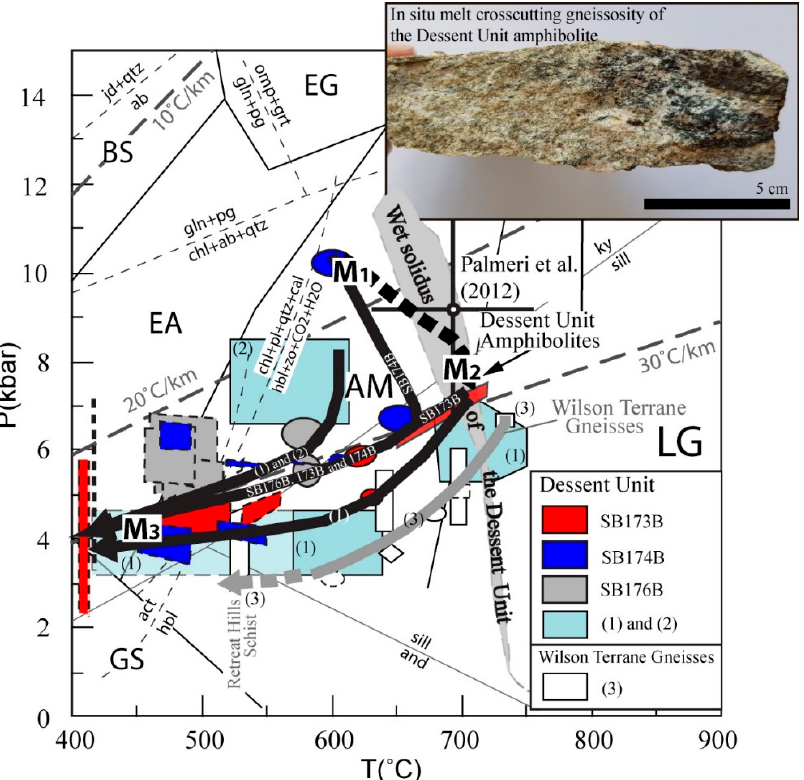
Figure 11. Summarized P–T paths of the Mountaineer Range, including the Dessent Unit and the Wilson Terrane gneisses. An amphibolite hand specimen hosting in situ melt collected from the Dessent Unit could represent its M 2 stage metamorphism. Prograde P–T conditions are presented as solid line polygons and retrograde P–T conditions as dot line polygons. Literature P–T conditions include (1) Scambelluri et al. [62]; (2) Capponi et al. [97]; (3) Castelli et al. [98]; (4) Palmeri et al. [59]. The P–T paths from the literature data are inferred by this study. Reference reaction curves: Plyusnina [99], Ernst [100], Spear [101] and Bucher and Frey [102]. Petrogenetic grid: Oh and Liu [103]. Abbreviations: BS, blueschist facies; EG, eclogite facies; EA, epidote amphibolite facies; GS, greenschist facies; LG, low-pressure granulite facies; jd, jadeite; gln, glaucophane; omp, omphacite; pg, paragonite; cal, calcite; act, actinolite; ky, kyanite; sill, sillimanite; and, andalusite. Other mineral abbreviations are the same as those in Figure